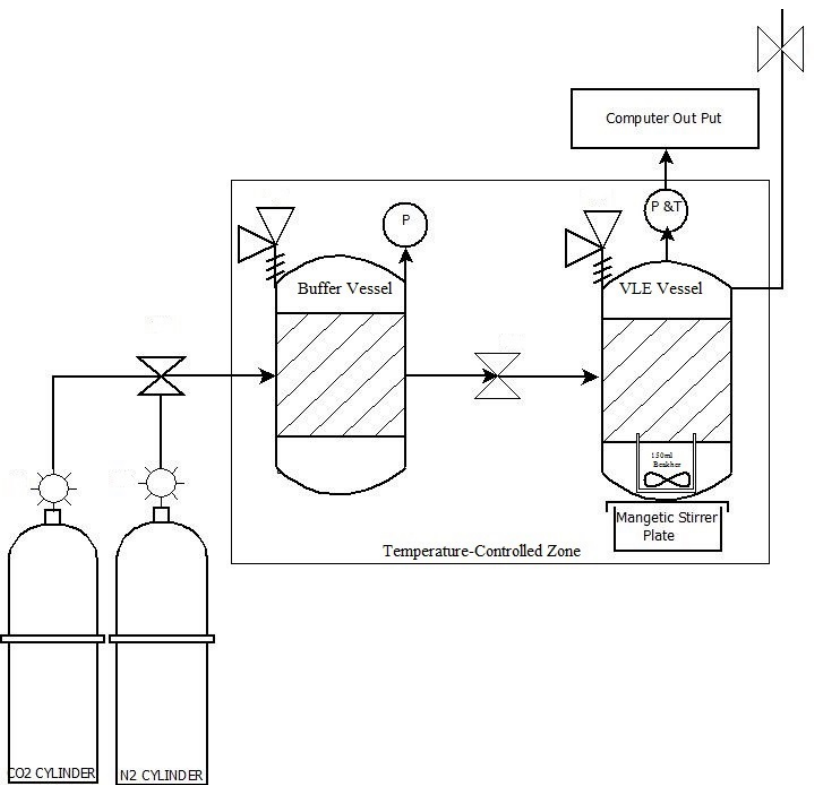
Figure 1. Schematic diagram of the VLE absorption rig to measure CO 2 absorption by DES systems. Adopted with modification from [30].